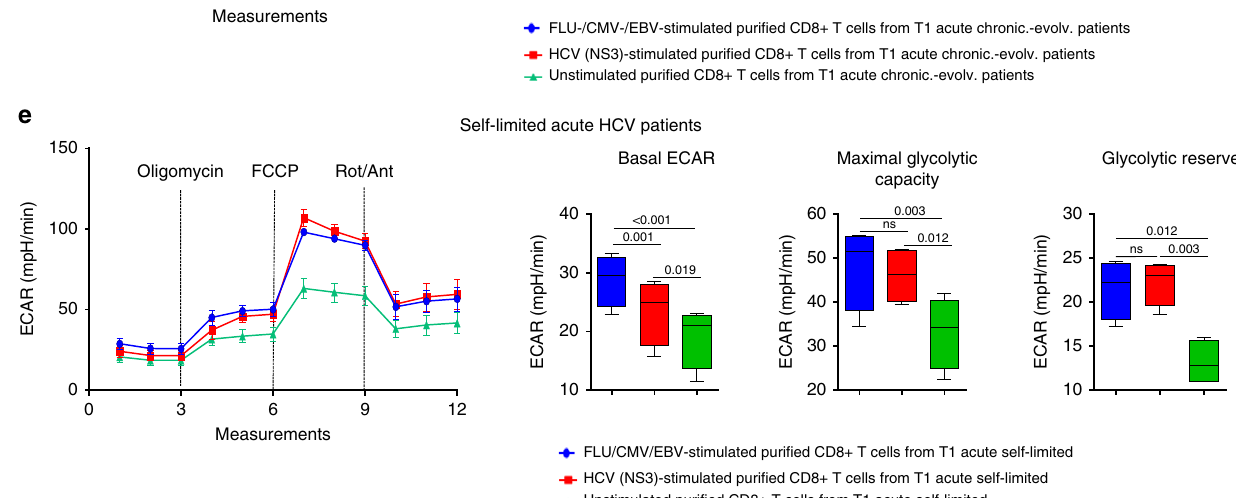
Fig. 2 Glucose metabolism is impaired in HCV-speci fi c CD8 + T cells from chronically evolving acute patients. a Representative examples of virus- speci fi c CD8 + T cells stained with HLA-A2 + dextramers ex vivo after overnight anti-CD3/anti-CD28 stimulation. Glucose uptake ( b ), measured by the incorporation of the glucose analog 2-NBDG (MFI), and Glut1 expression levels ( c ) in virus-speci fi c CD8 + T cells from T1/early HCV patients and healthy controls stimulated as in a . Data are presented as median fl uorescence intensity (MFI) values; median values are indicated by horizontal lines. Different numbers of patients (represented by individual dots) were tested in each assay depending on dextramer-positive cell frequencies. b – c Differences between multiple groups were evaluated with the non-parametric Kruskal-Wallis test; p -values were corrected for pairwise multiple comparisons with the Dunn ’ s test. d metabolic fl ux pro fi ling of puri fi ed CD8 + T cells from 6 T1/early chronically-evolving (acute) patients. Cells were stimulated overnight with either HCV-NS3 (red) or control (FLU-speci fi c, CMV-speci fi c and EBV-speci fi c) peptides (blue), or were not stimulated (green). The extracellular acidi fi cation rate (ECAR) was measured in real-time ex vivo before (basal level) and after oligomycin treatment in order to determine the maximum glycolytic capacity (MGC) and glycolytic reserve (difference between MGC and baseline ECAR) (see Methods section for details on Seahorse analysis). e Metabolic fl ux pro fi ling of puri fi ed CD8 + T cells from T1/early self-limited (acute) patients ( n = 4) stimulated overnight as in d . ECAR, maximum glycolytic capacity and glycolytic reserve were measured as in d . In d and e , ECAR values are given as the mean ± SD in the left-side and are presented as box-and-whisker plots (with median and 5 – 95 percentile) in the right-side. d – e Statistical analysis was performed with the Friedman test to compare different stimuli; p -values have been corrected for pair-wise multiple comparisons with the Conover ’ s